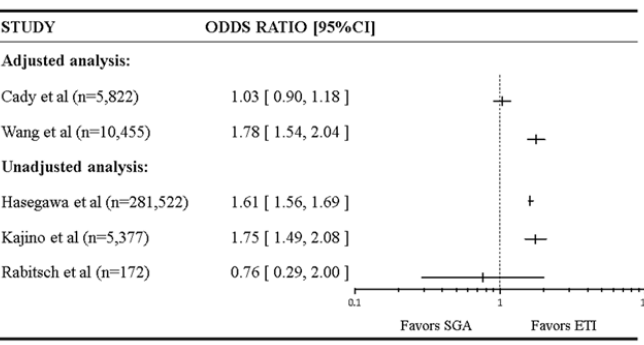
Figure 2a. Associations of pre-hospital advanced airways [endotracheal intubation (ETI) versus supraglottic airways (SGA)] with return of spontaneous circulation.